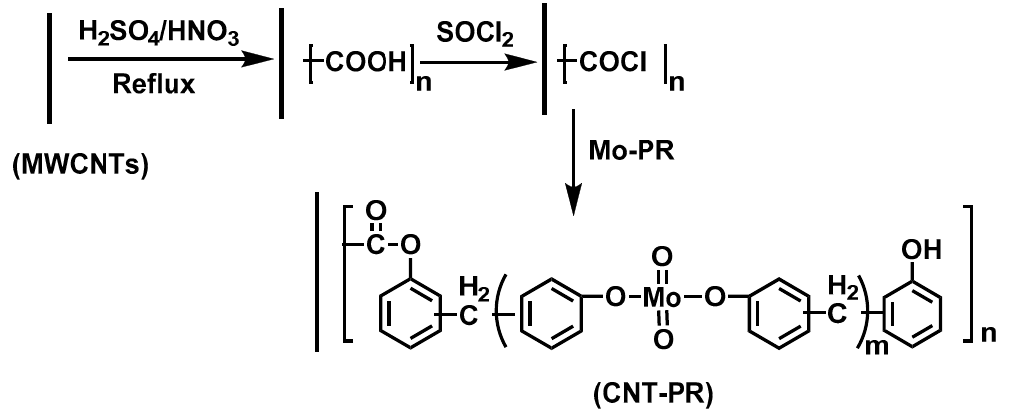
Figure 13. Reaction scheme of epoxy/CNT composites. Readapted with permission from Ref. [122], Copyright 2011, Elsevier Ltd.